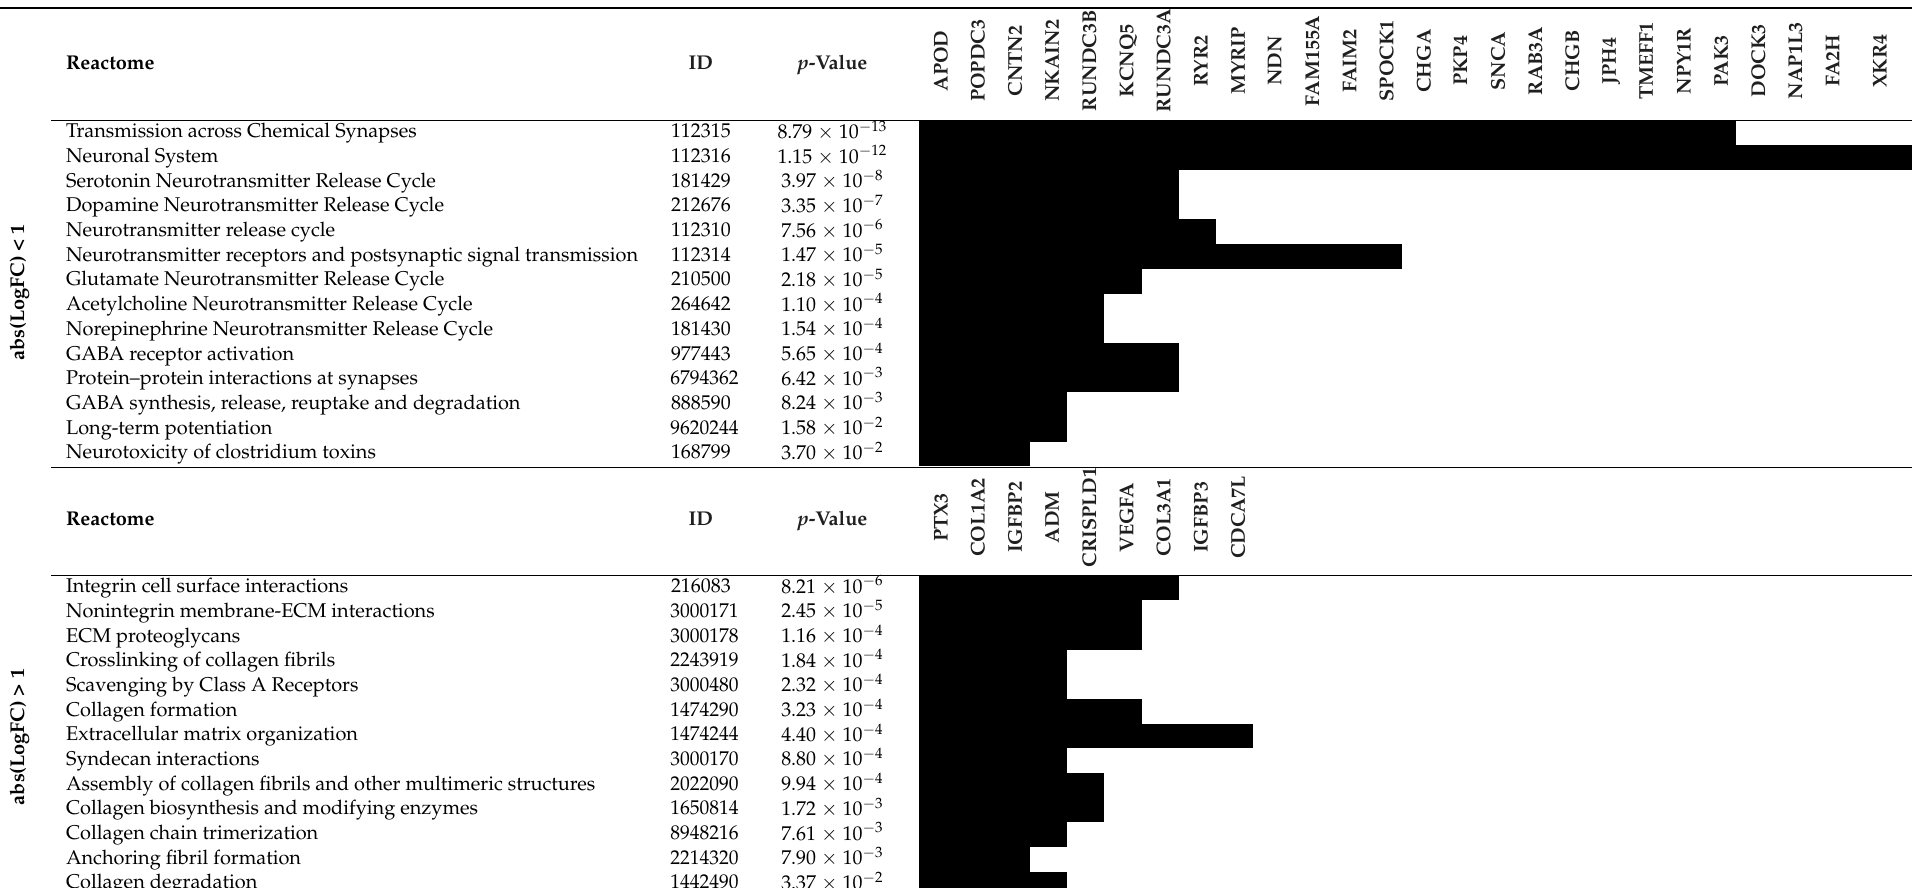
Table 1. Functional enrichment analysis of